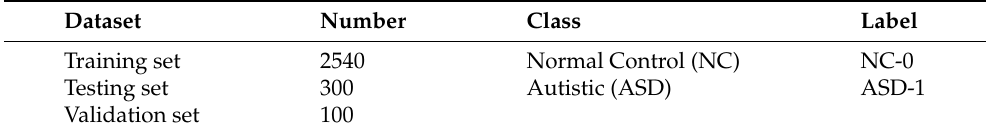
Table 2. Characteristics of the Kaggle image datasets used during the study.